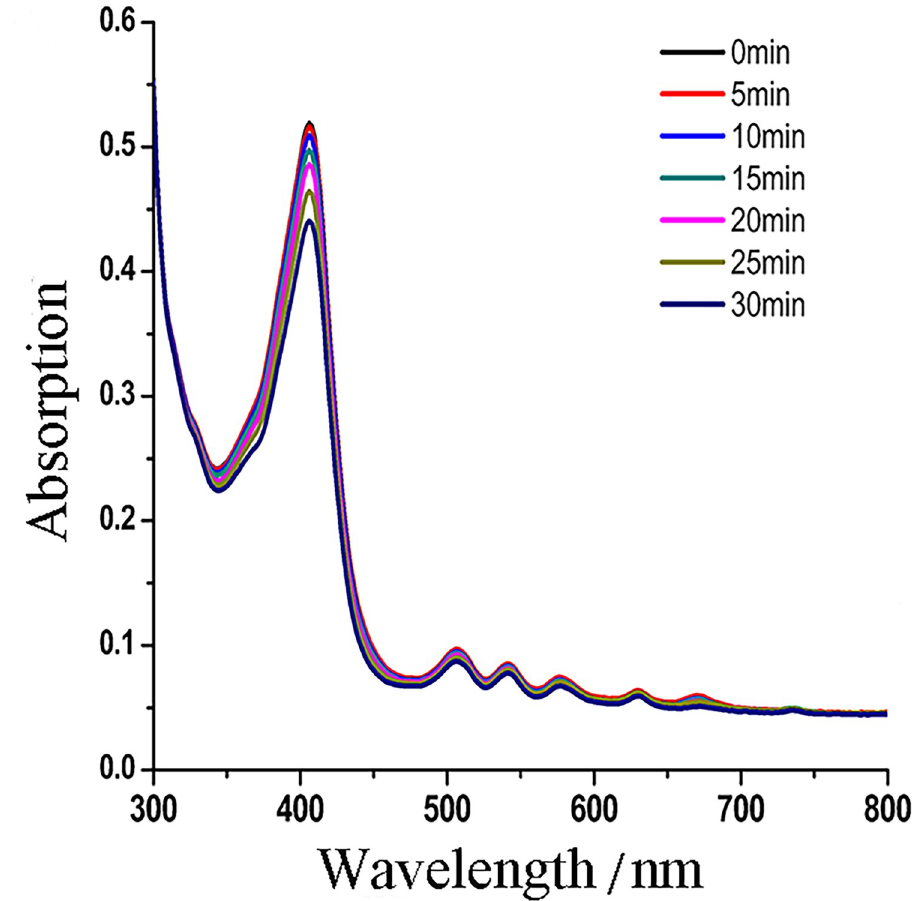
Fig 3. Photobleaching of protoporphyrin IX–ethylenediamine derivative (PPIX-ED). A photobleaching experiment was performed using a multimode microplate spectrophotometer. The photostability profiles of PPIX-ED under different irradiation times were obtained (2 × 10 − 5 mol/L PPIX-ED, 4.2 mW/cm 2 light energy density). The absorption spectrum of PPIX-ED spanned 0–30 min.